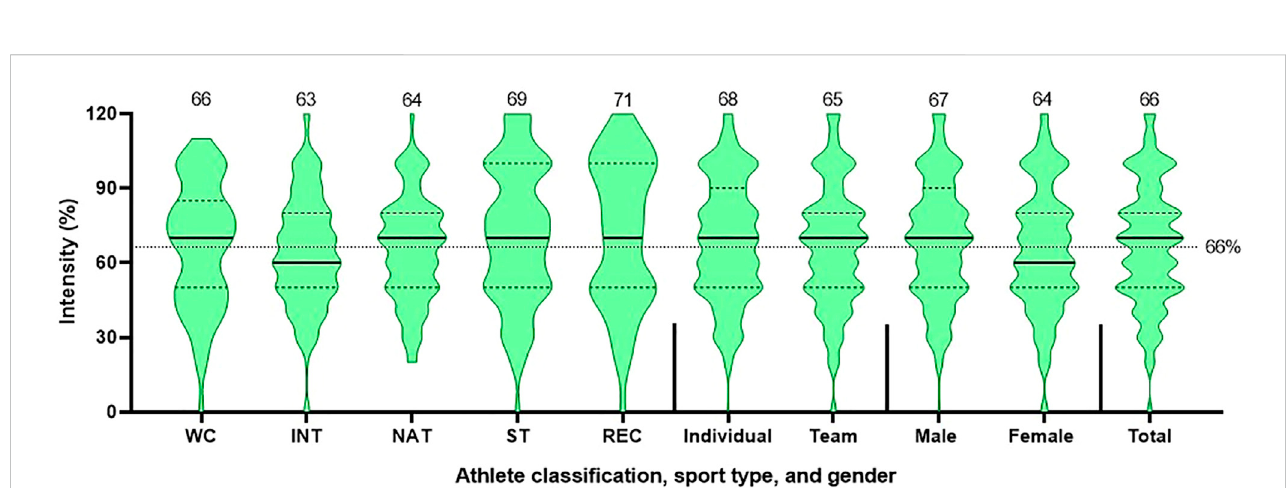
FIGURE 2 Training intensity depicted by athlete classi fi cation, sport-type, gender, and total cohort ( n = 665). (Question: Do/did you maintain your pre-lockdown intensity for sports speci fi c training (practicing your sport) during the lockdown? Can you estimate how much in percentage? (100% represents the same intensity as before the lockdown). Note: The violin plot includes a 5-point summary, which represents thenumber in dataset: minimum (lower extreme); 25% percentile ( fi rst dashed line/lower quartile); median (black thick line); 75% percentile (second dashed line/third quartile); and maximum (upper extreme). The thin dotted line across all charts/violins represents average